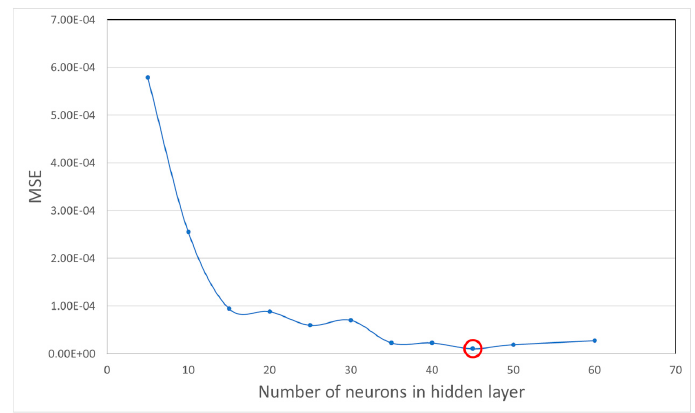
Figure 8 . Mean square error for differnt numbers of neurons in hidden layers. Figure 8. Mean square error for differnt numbers of neurons in hidden